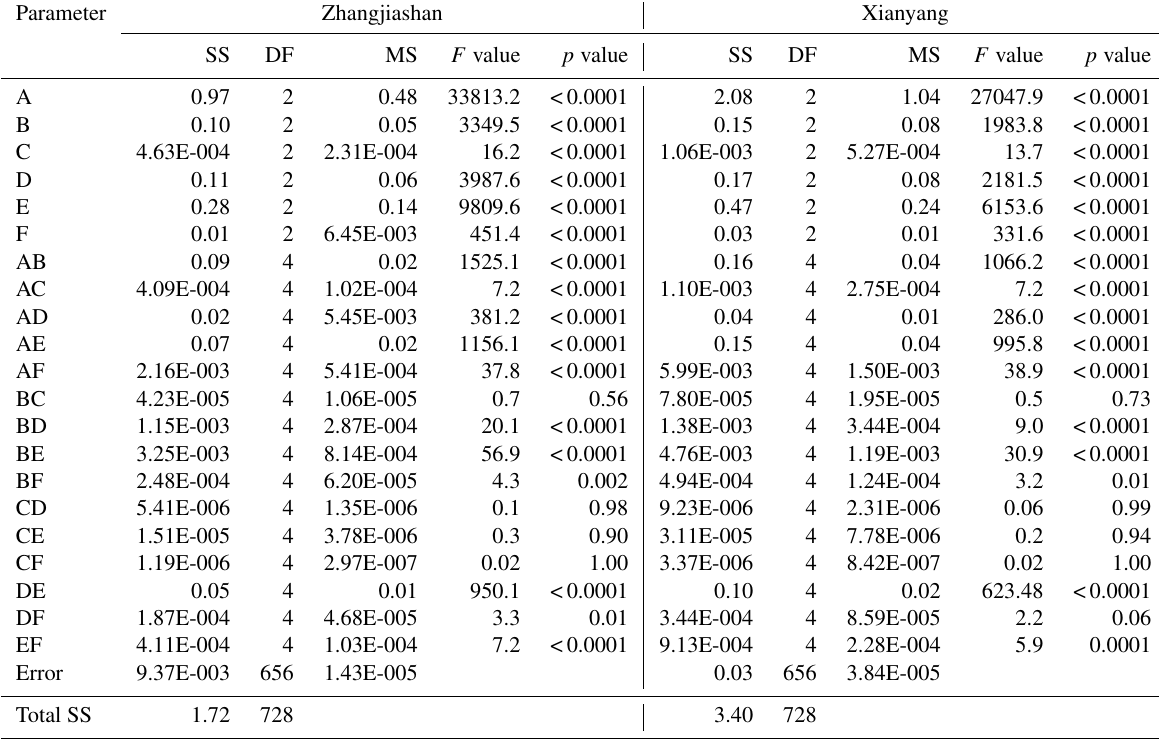
Table 6. ANOVA table for failure probability in Kendall: A indicates the shape parameter in GEV, B indicates the scale parameter of GEV, C indicates the location parameter of GEV, D means the meanlog of LN, E means the sdlog of LN, and F means the parameter (i.e. theta) in